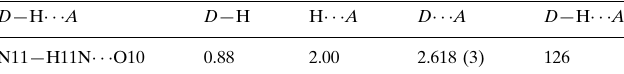
Hydrogen-bond geometry (A˚ , (cid:2)